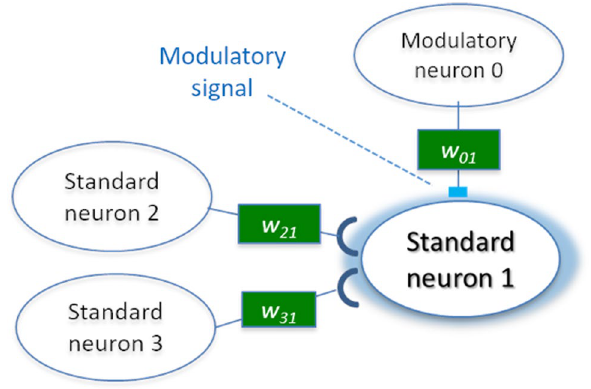
Figure 6. Overview of the